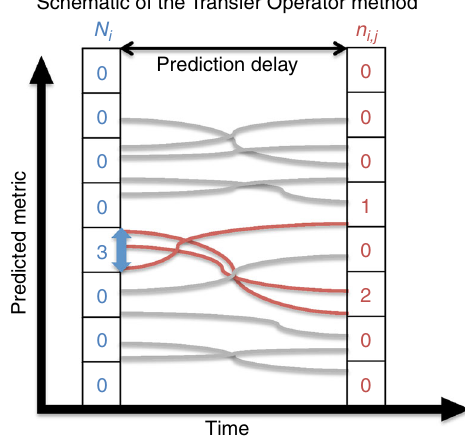
Fig. 2 Schematic of the Transfer Operator method. The computation of the transfer operators follows four steps: fi rst, the predicted metric (GMT and SST) is split in a number of different states based on its intensity (8 in the schematic, 24 for the real forecast system); then, the number of trajectories from the CMIP5 database in each state is counted ( N i , blue numbers); as a third step, for each state, the number of corresponding trajectories found after the prediction delay is counted ( n i , j , red numbers); fi nally, the probability of transition from i th state to j th is given by n i , j / N i . This sequence is repeated for 10 different prediction delays and 10 averaging times of trajectories (both are varied from 1 to 10 years, by 1 year time step) building the range of transfer operators required for